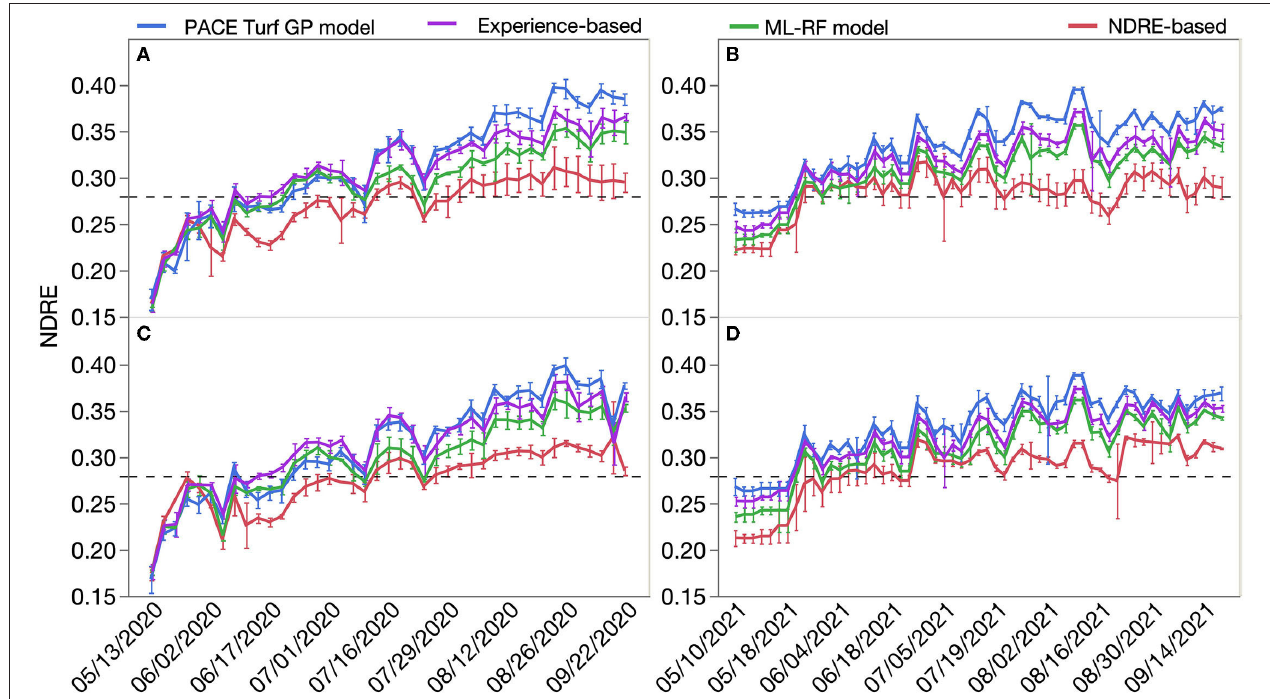
FIGURE 3 | NDRE readings of creeping bentgrass response to four nitrogen (N) application strategies: the PACE Turf growth potential (GP) model, traditional N fertilization plan (experience-based), machine learning-random forest (ML-RF) model, and vegetative index (NDRE)-based strategy). (A) NDRE readings on root zone A in 2020. (B) NDRE readings on root zone A in 2021. (C) NDRE readings on root zone B in 2020. (D) NDRE readings on root zone B in 2021. The dashed line is the NDRE decision threshold of 0.28. Error bars indicate standard